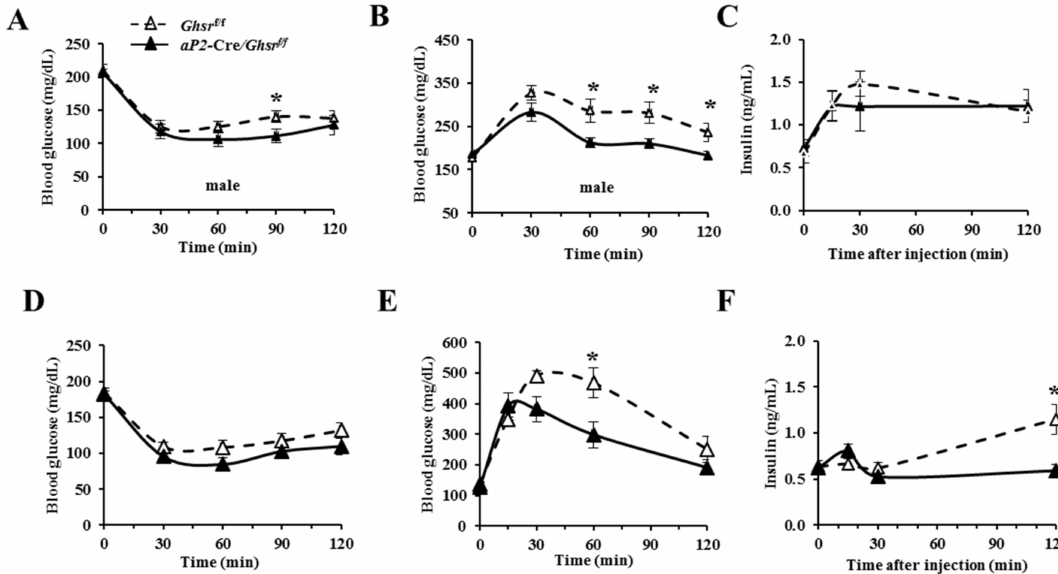
Figure 4. Glycemic profiles of young and old aP2 -Cre/ Ghsr f/f mice. ( A ) Blood glucose during insulin tolerance tests (ITT), and blood glucose ( B ) and insulin ( C ) during glucose tolerance tests (GTT) of 5–6 months-old young male Ghsr f/f and aP2 -Cre/ Ghsr f/f mice; ( D ) blood glucose during ITT, and blood glucose ( E ) and insulin ( F ) during GTT of 15–17 months-old male Ghsr f/f and aP2 -Cre/ Ghsr f/f mice. n = 7. * p < 0.05, Ghsr f/f vs. aP2 -Cre/ Ghsr f/f . The results were represented as mean ± S.E.M. Repeated measurement-ANOVA was used for statistical